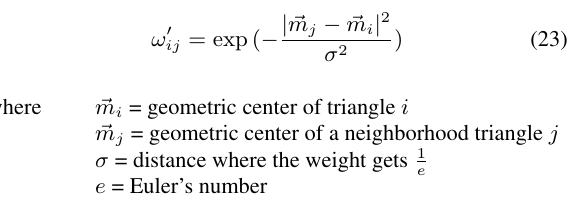
Figure 13. Reference triangle and deformed triangle with shifts along crack direction, the edge (cid:126)s 12 ref is shifted to the edge (cid:126)s 12 in the deformed